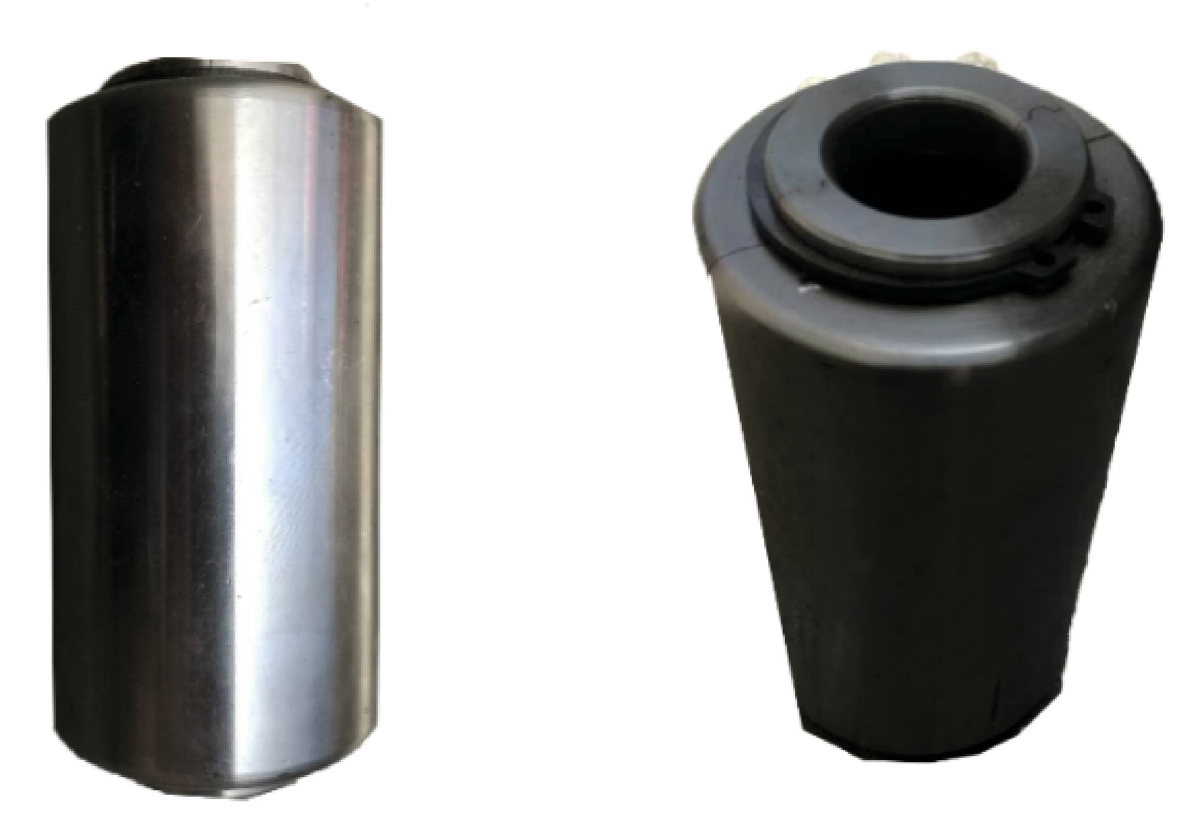
Figure 18: Ultra-high-pressure rotating water tail